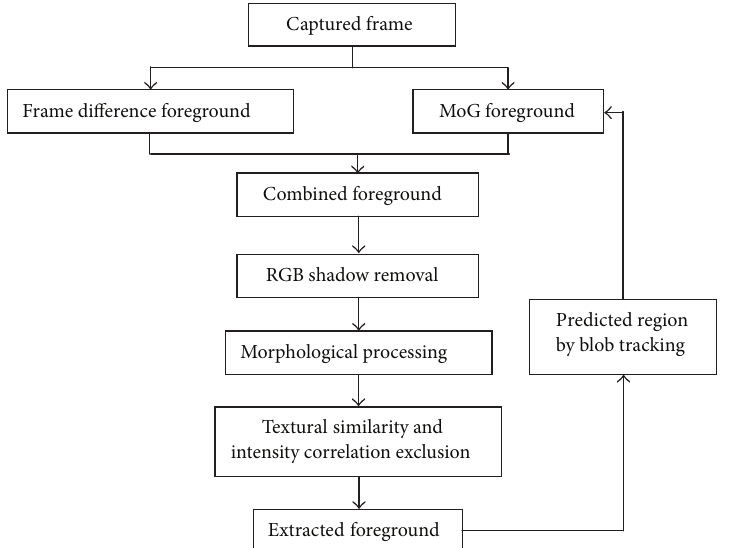
Figure 1: Flow chart of the proposed